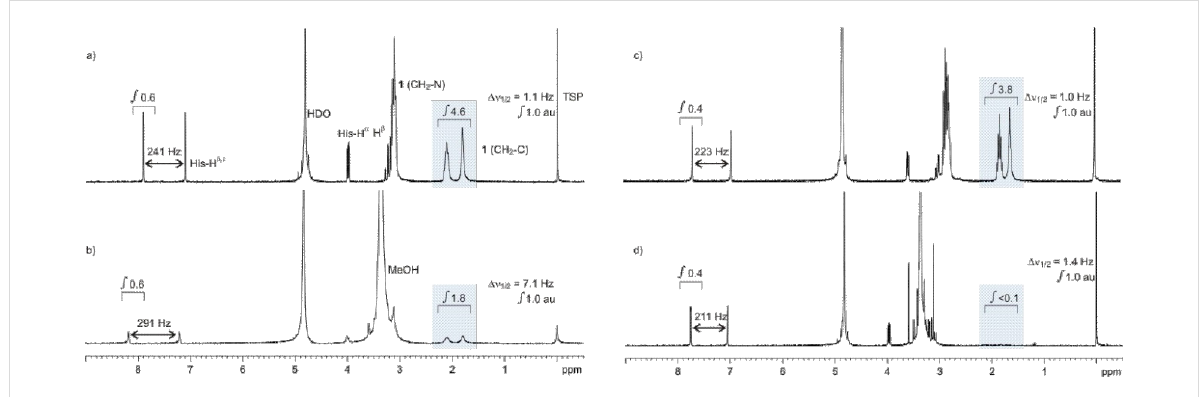
Figure 5: 1 H NMR spectra (300 MHz, 300 K) of 1 a) without and b) in the presence of orthosilicic acid at pH 6 and the same experimental setting at pH 11 c) and d). TSP serves as an internal standard and the signal intensity (integral) was set to 1 a.u. (arbitrary units). Histidine is present as a second internal standard because the splitting of the imidazole CH groups (His-H δ and His-H ε ) depends on the pH value in the region around the p K a value of the imidazole side chain. Signals of 1 which are not influenced by the resonance of the released methanol from the TMOS hydrolysis are highlighted by a blue box. Further details are given in the text.